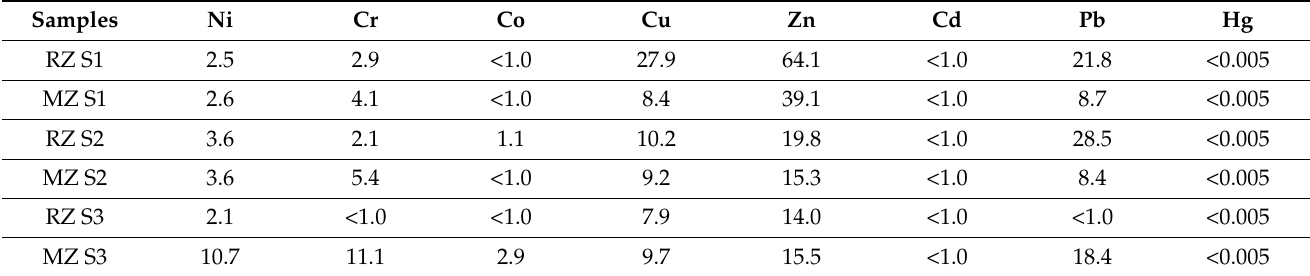
Table 2. Trace element concentrations of RZ and MZ